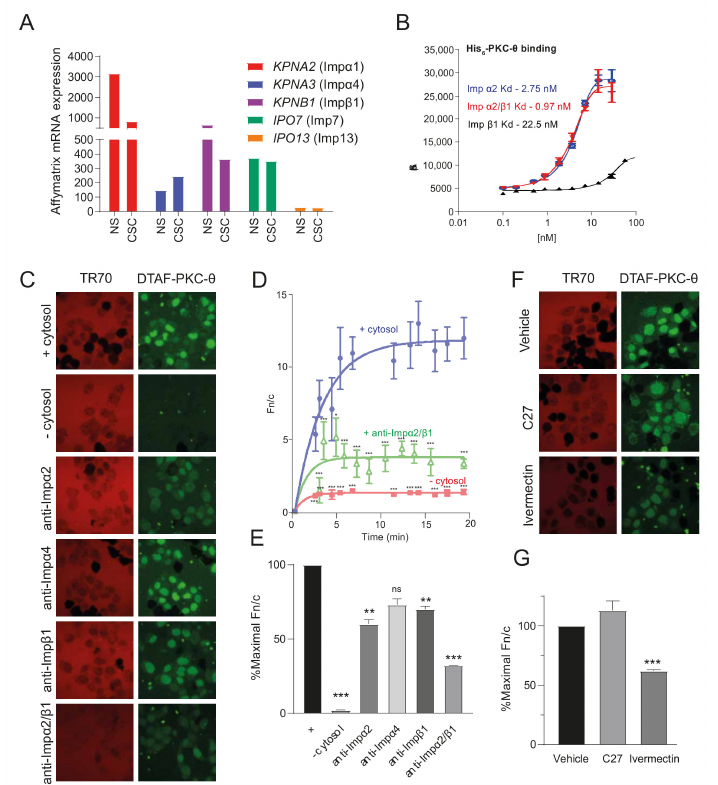
Figure 2. PKC- θ shows high affinity binding to the Imp α / β 1 heterodimer and dependence on Imp α / β for nuclear accumulation in vitro. ( A ) Affymetrix microarrays previously in MCF-7 cells treated with PMA and FACS sorted into CD44 high and CD24 low cancer stem cells (CSC) and non-stem cancer cells (NS), respectively were used to profile the mRNA expression of importins [6]. Graphs plot the